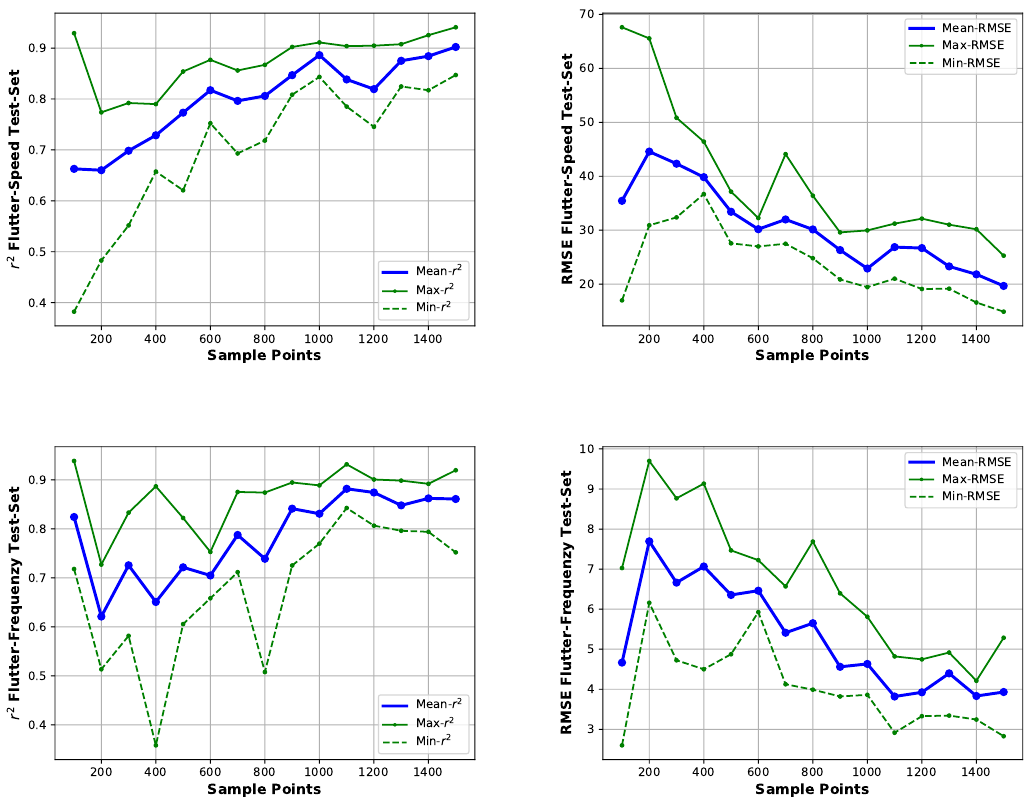
Figure 6. Cross-validation results for the objective flutter-speed and